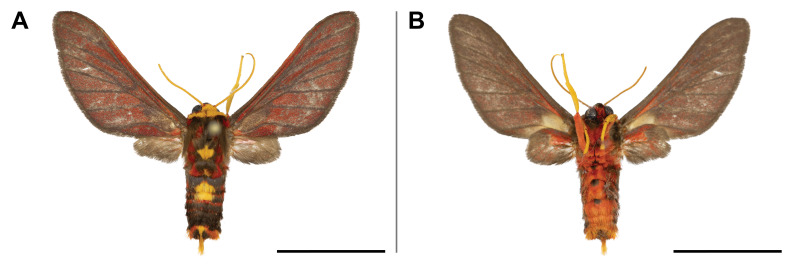
Daphaenisca
inexpectata (Durante & Zangrilli, 2016). A. dorsal view; B. ventral view. The scale bar represents 1 cm.